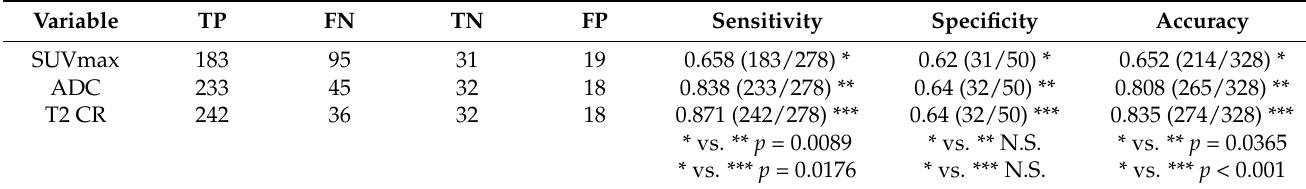
test (Table 5). Concerning comparison of sensitivity among SUVmax ADC and T2 CR, the sensitivity (0.658 (183/278)) of SUVmax was significantly lower than that (0.838 (233/278)) of ADC ( p < 0.001), and significantly lower than that (0.871 (242/278)) of T2 CR ( p < 0.001). Concerning the comparison of specificity among SUVmax, ADC, and T2 CR, the specificity (0.620 (31/50)) of SUVmax was the same as that (0.640 (32/50)) of ADC (not significant) and the same as that (0.640 (32/50)) of T2 CR (not significant). Concerning the comparison of accuracy among SUVmax, ADC, and T2 CR, the accuracy (0.652 (214/328)) of SUVmax was significantly lower than that (0.808 (265/328)) of ADC ( p < 0.001) and significantly lower than that (0.835 (274/328)) of T2 CR ( p < 0.001). Table 5. Sensitivity, specificity, and accuracy of PNMs using their OCVs. Specificity